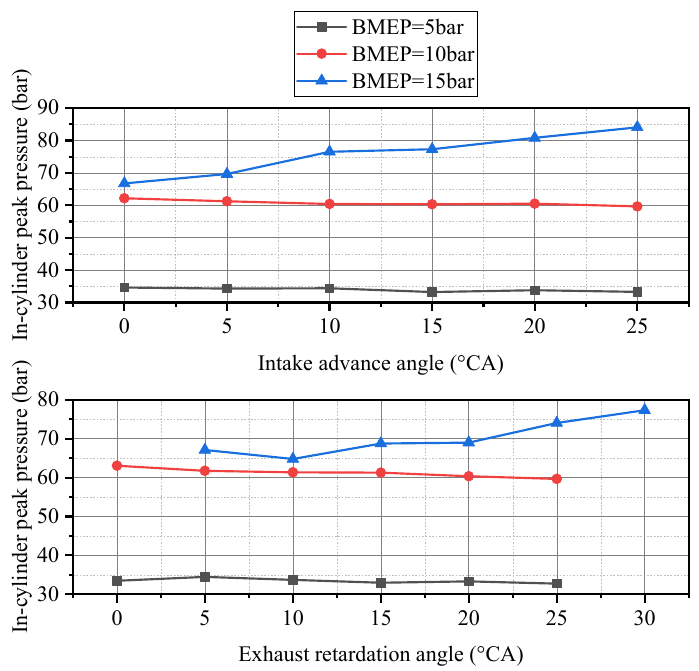
Figure 10. In-cylinder peak pressure versus intake advance angle under baseline EVC, and in-cylinder peak pressure versus exhaust retardation angle under the Miller cycle at different points of operation during the test.